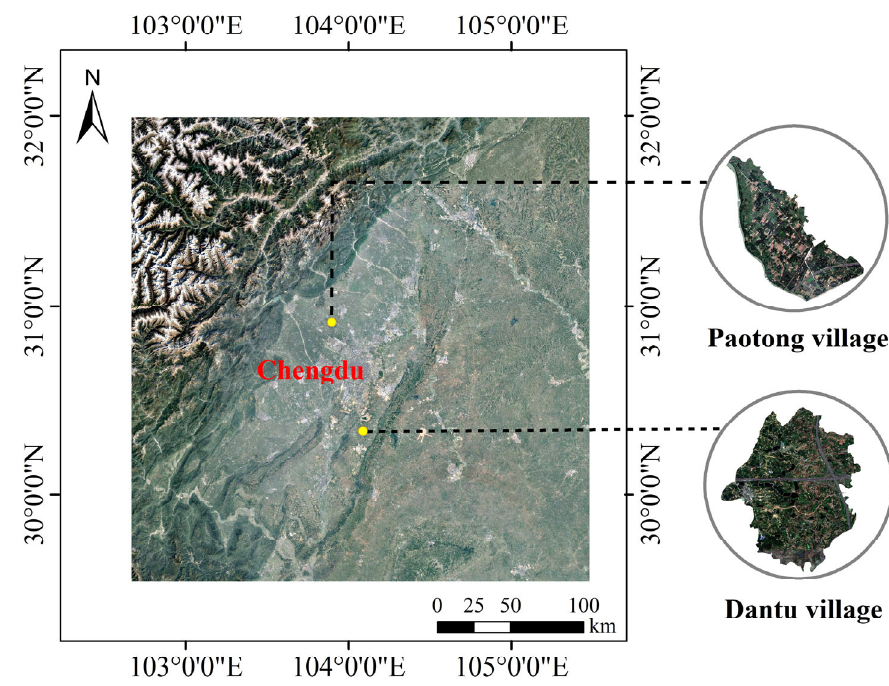
Figure 1. Location of case study sites in Chengdu Plain.